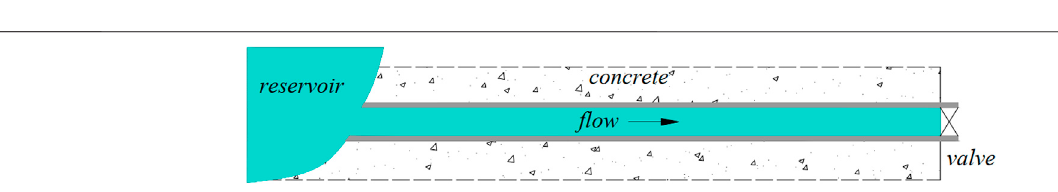
FIGURE 4 | Time history of pressure (A) Impact end. (B) Remote end.